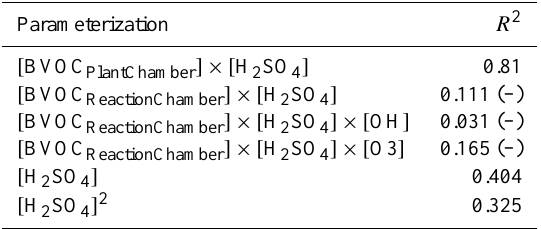
Table 2. Coefficients of determination ( R 2 ) between the observed nanoCN formation rate ( J ) and different parameterizations of nu- cleation